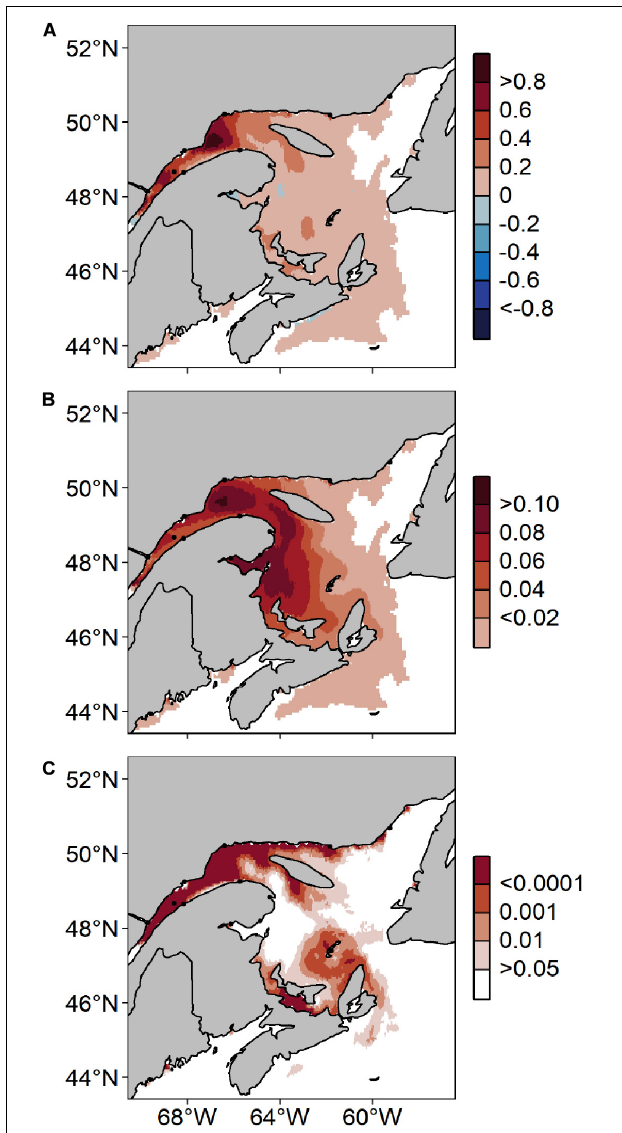
FIGURE 12 | Predicted changes along Canada’s East coast in mean annual risk days with Alexandrium catenella ≥ 1000 cells L − 1 throughout the period 2001–2099 under MPI-ESM-LR RCP 8.5: (A) rate of change (number of days y − 1 ), (B) standard error and (C) p -value based on the linear regression for each model